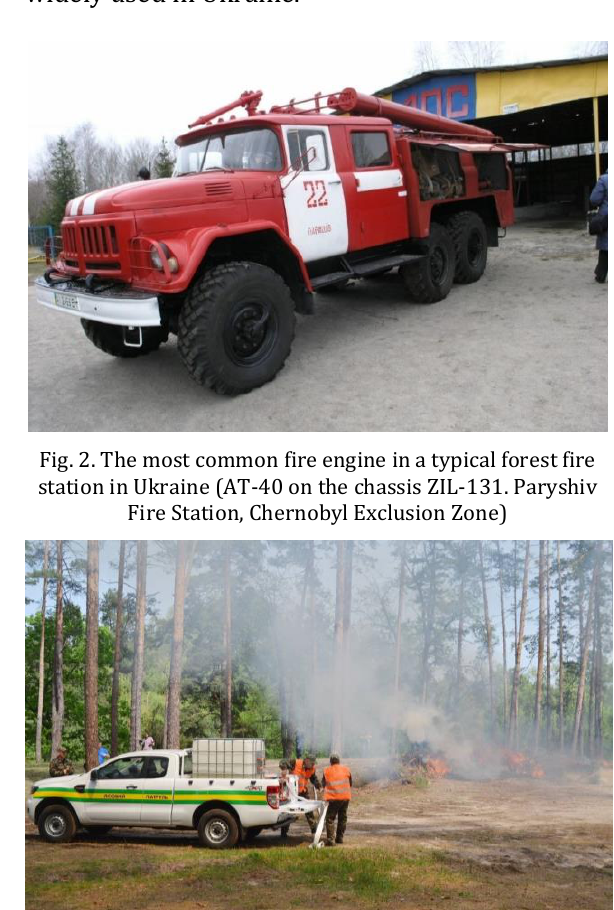
Fig. 3. Forest fire patrol car with a pick-up fire suppression unit as used in Cherkassy Oblast (Source: